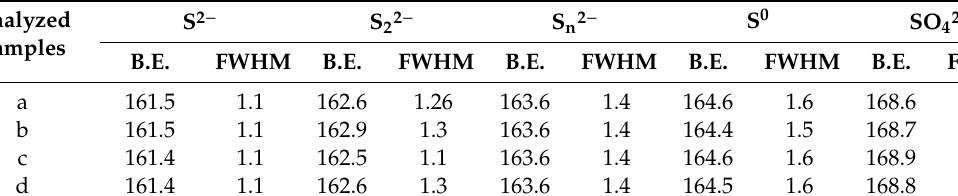
Table 3. Binding energy and full width at half maxima of sulfur specie in XPS profiles.